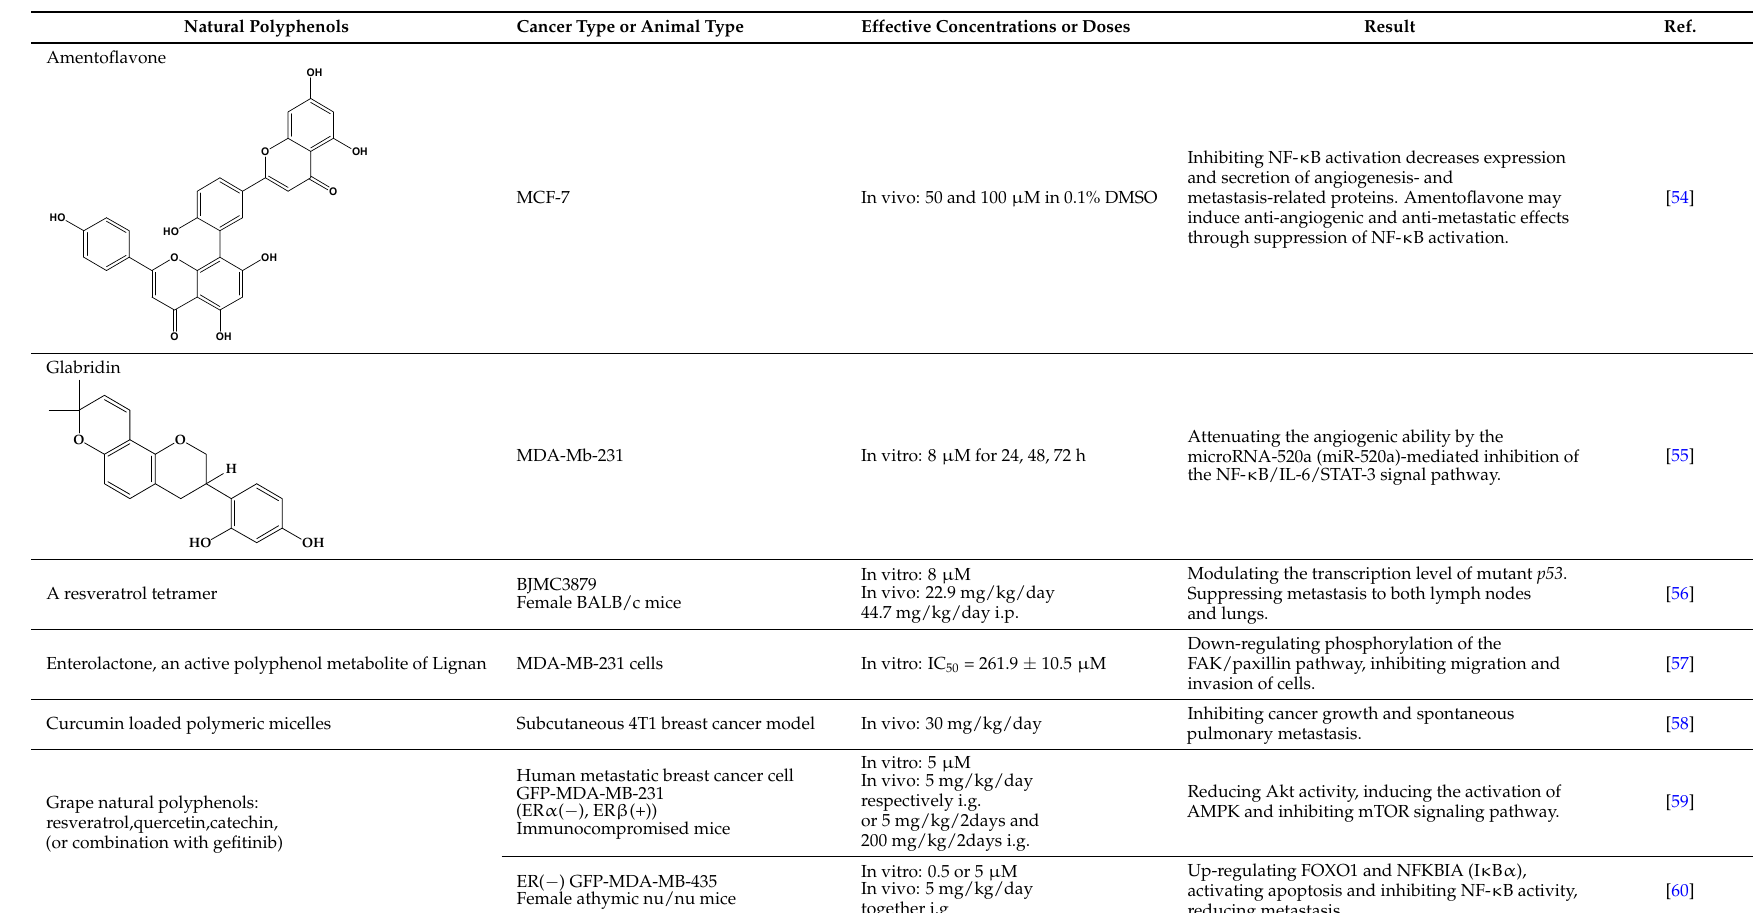
Table 1. Cont. Natural Polyphenols